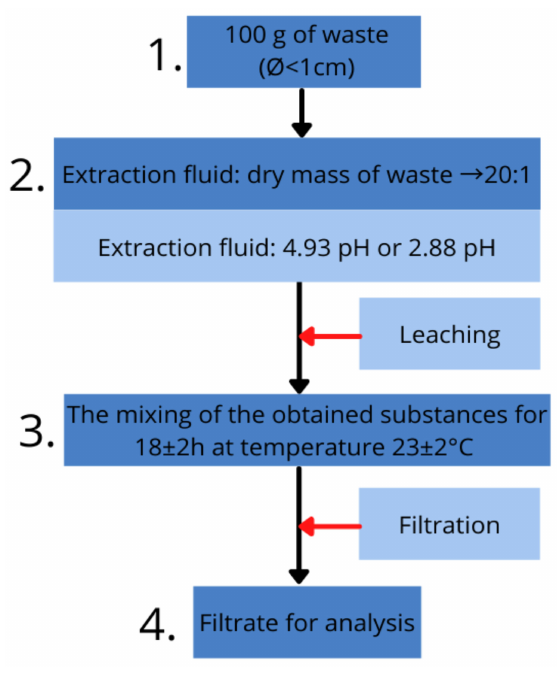
Figure 4. Diagram of TCLP